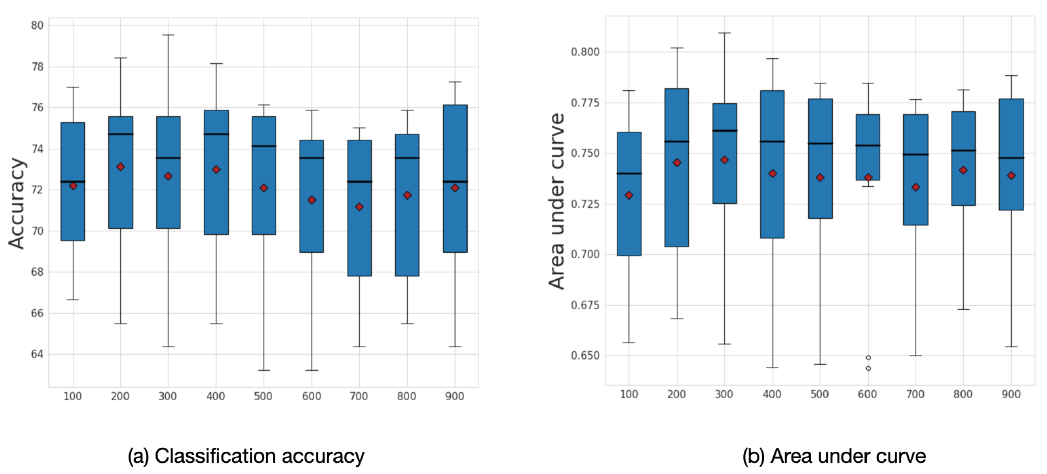
Figure 9. Sensitivity analysis for k . Average accuracy and AUC results with respect to the frequency filtering threshold k . The mean values are shown as a red